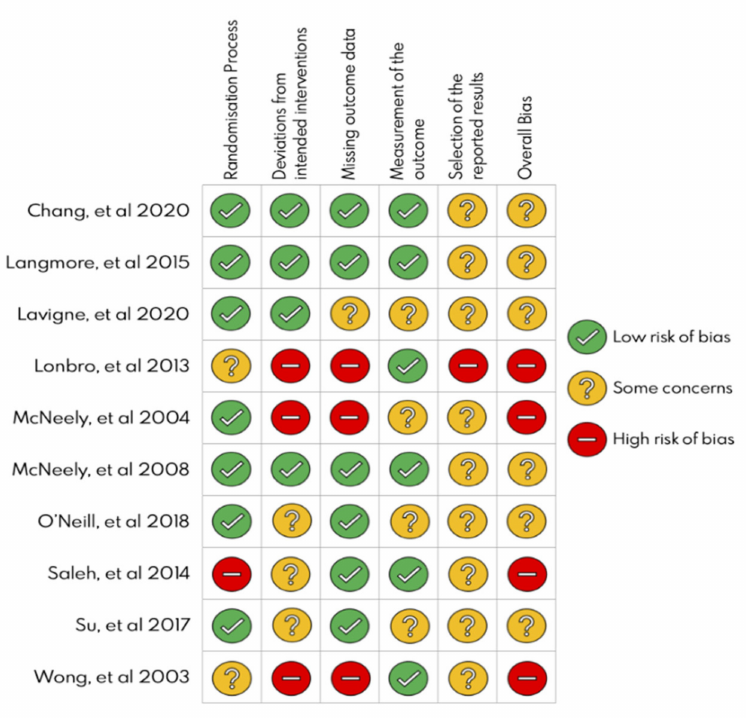
Figure 3. Risk of bias summary of the included